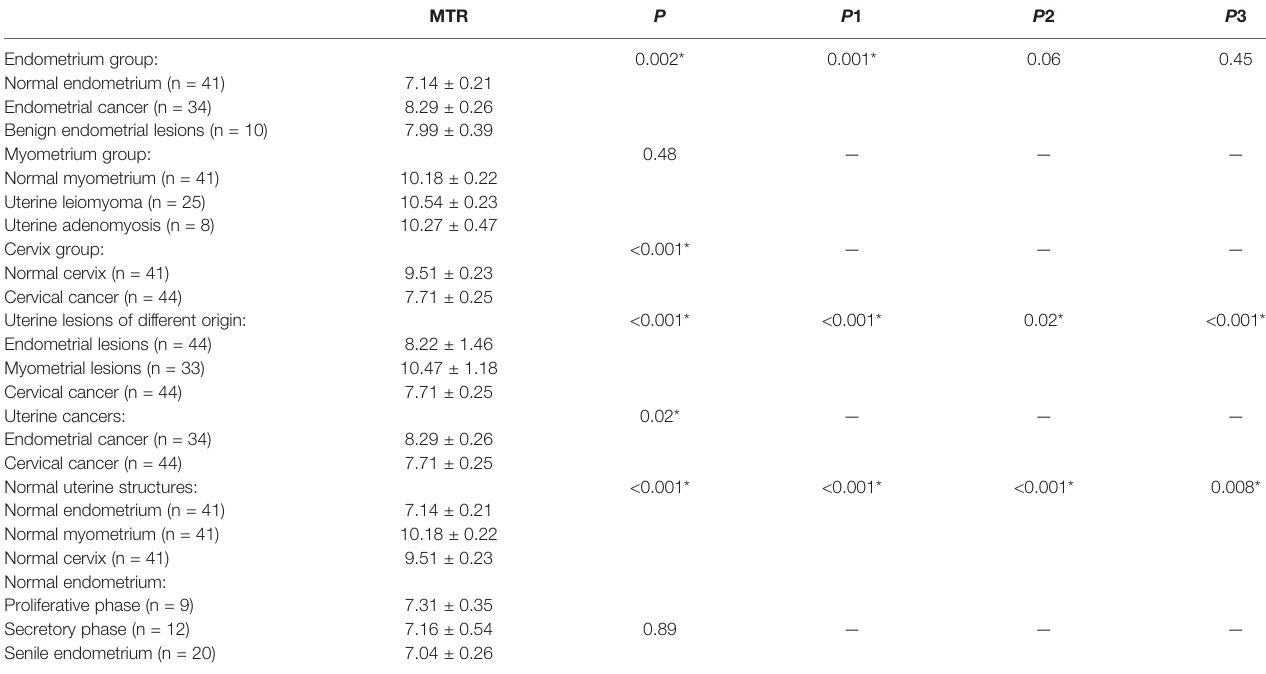
TABLE 4 | Comparison of MTR values among different groups.